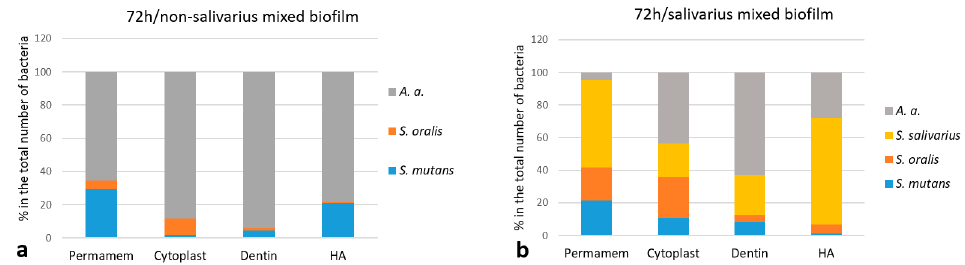
Figure 3. Distribution (%) of individual bacterial species on Permamem and Cytoplast d-PTFE membrane, dentin and hydroxyapatite ( n = 9); ( a ) 72-h non-salivarius mixed biofilm; ( b ) salivarius mixed biofilm.